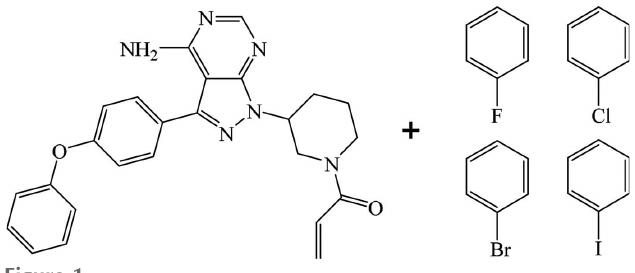
Figure 1 Molecules of ibrutinib and the solvents used (FBZ, CBZ, BBZ and